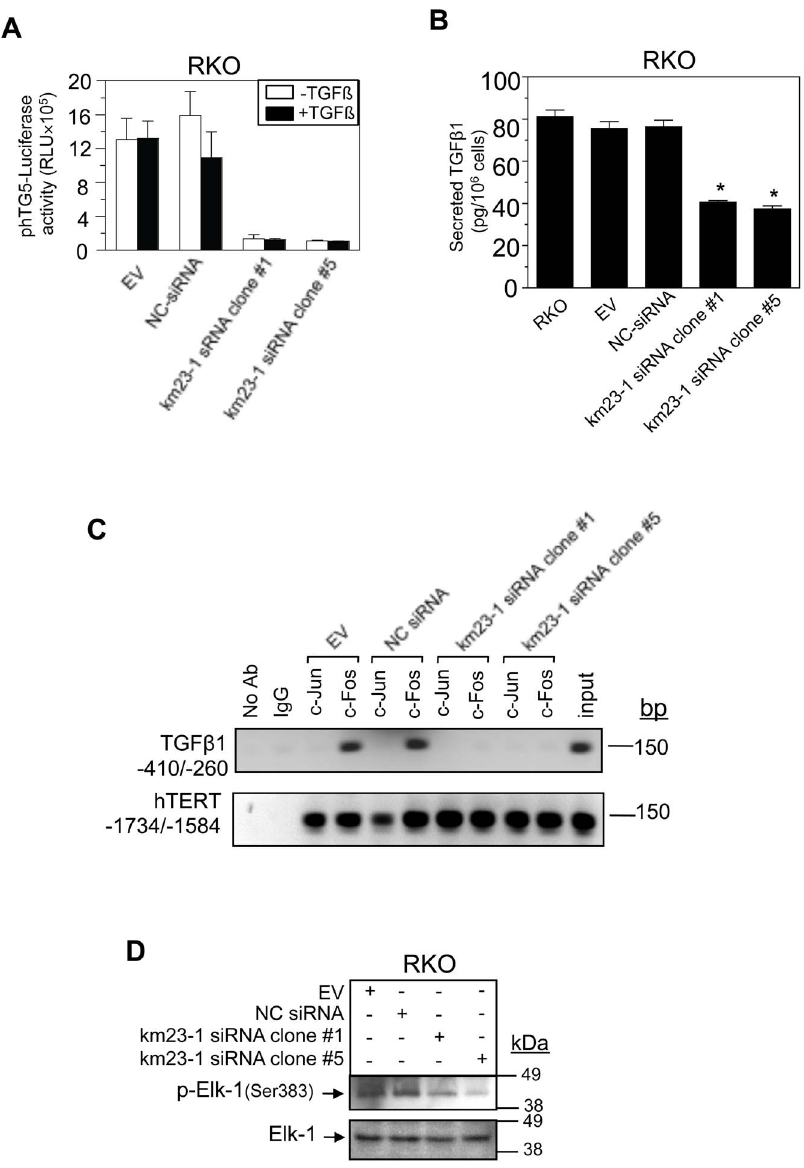
Figure 2. Depletion of km23-1 in RKO human CRC cells inhibits transactivation of the proximal AP-1 site in the TGF b 1 promoter, TGF b 1 secretion, c- Fos-DNA binding to the TGFß1 promoter, and Elk-1 activation. A: RKO stable transfectants were transiently transfected with phTG5-Lux and luciferase assays were performed as described previously [20,40]. Data are representative of three independent experiments. B: TGF b 1 concentrations in CM from RKO stable transfectants were measured by ELISAs as described previously [20,40]. *p , 0.01 compared to the NC siRNA. C: ChIP assays were performed [20,40] using either the human TGF b 1 promoter region from 2 410 to 2 260 (upper panel) or the hTERT promoter region from 2 1734 to 2 1584 (lower panel) with the indicated antibodies. Input: Equal samples of chromatin DNA without prior immunoprecipitation. D: Western blotting of phospho- and total protein expression levels for Elk-1 in RKO human CRC cells. Three independent experiments were performed and representative figures are shown.